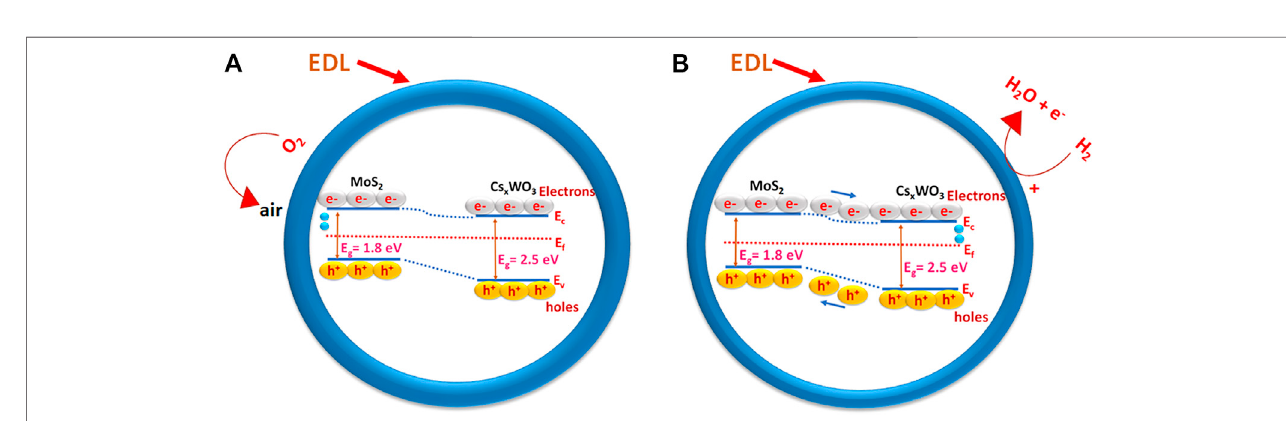
FIGURE 10 | Schematic illustration of Cs x WO 3 /MoS 2 -based gas sensor (A) in air, and (B) in H 2 gas.